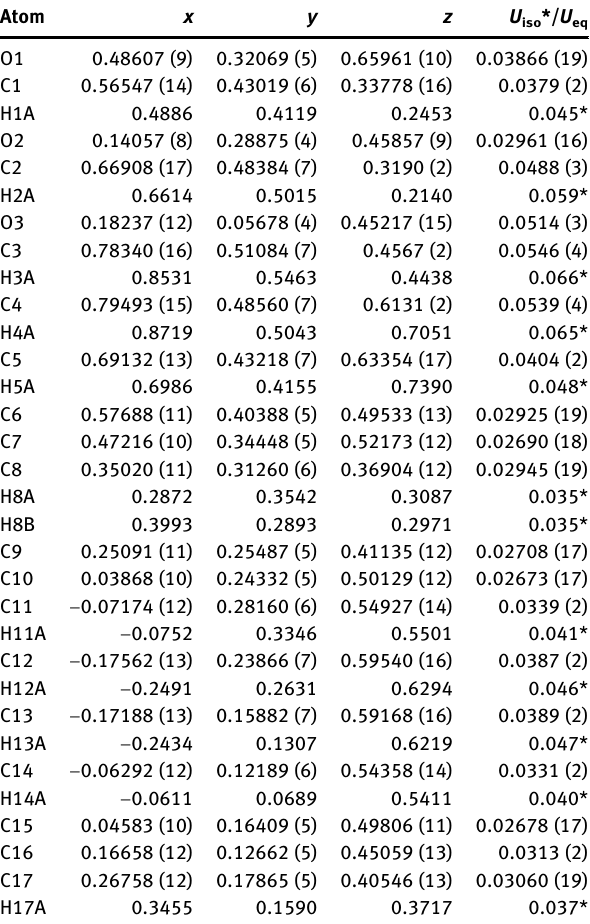
Table  : Fractional atomic coordinates and isotropic or equivalent isotropic displacement parameters (Å  ).